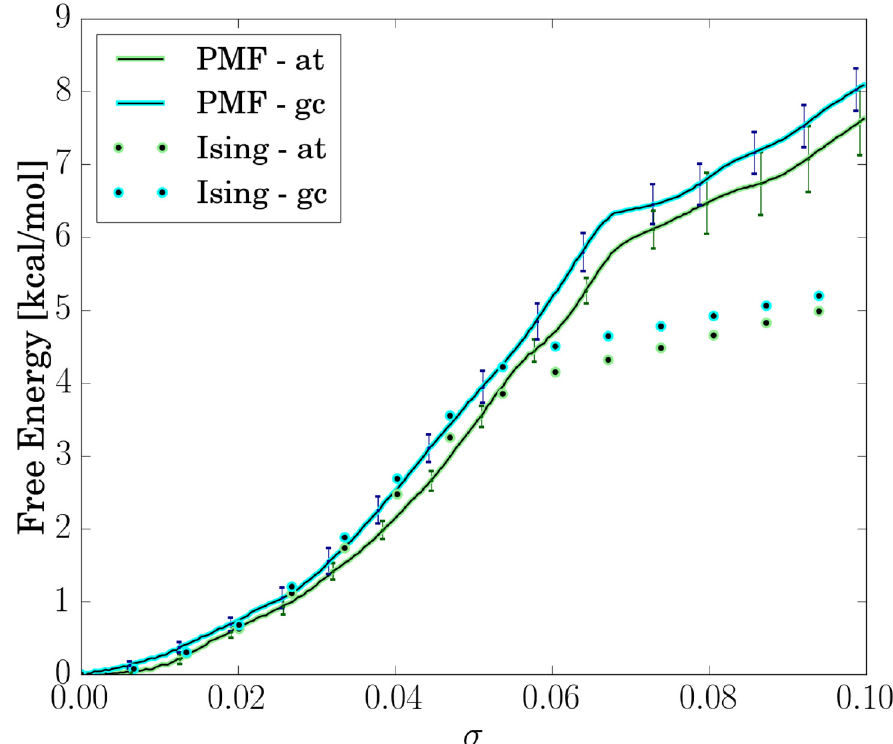
Fig 9. Free energy profiles for global unwinding of the DNA molecules ( σ ) obtained from US simulations (PMF) and calculated by Ising models. Error bars of the PMFs have been calculated by thermodynamic integration and block-averaging